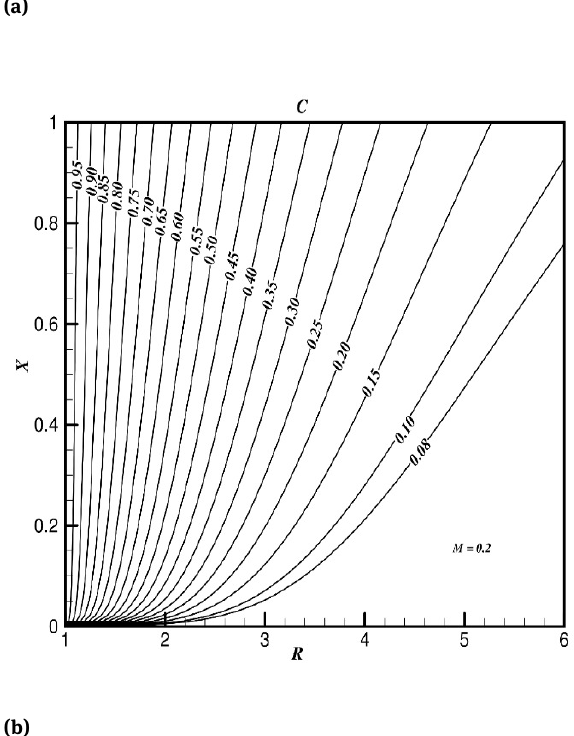
Figure 18: Steady state concentration contours ( a ) M = 0.0 ( b ) M = 0.2 for fixed Sc = 0.6 , Pr = 0.7 , Bu = 1.0 , Kr = −0.2 , Nr = 2.0 , K 1 = 1.0 , Ec = 0.1